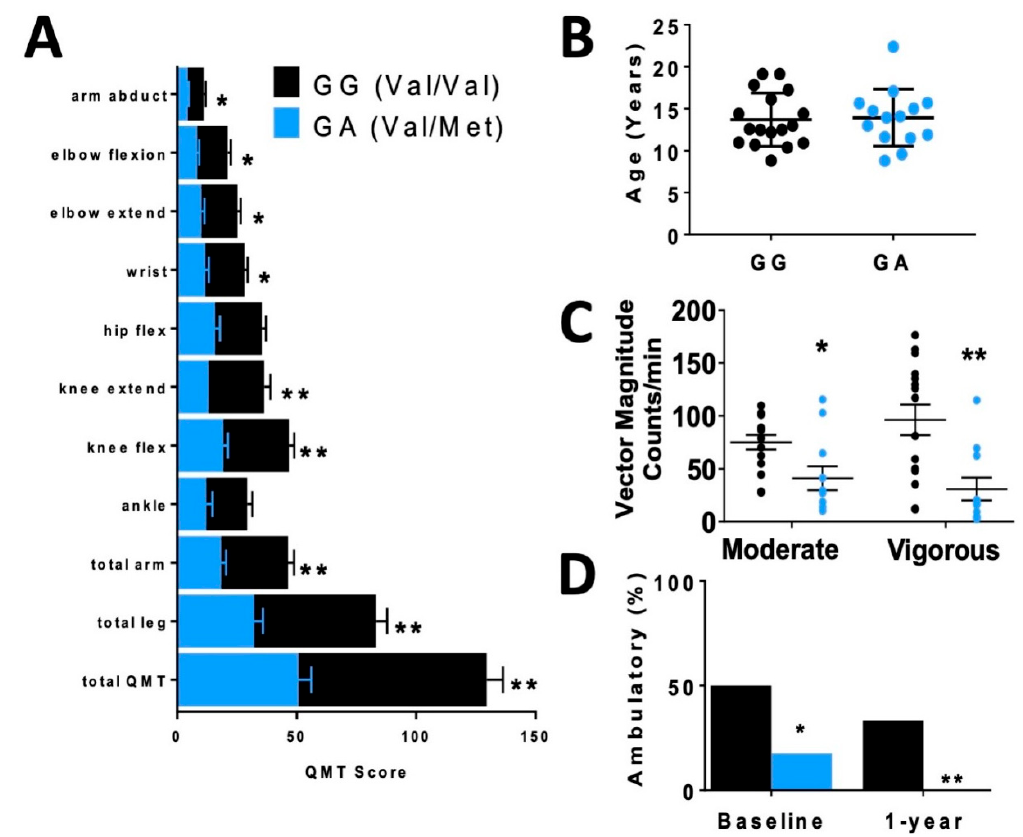
Figure 2. Disparate skeletal muscle performance in DMD patients when compared by rs6265 polymorphism. ( A ) Comparative bar graphs of quantitative muscle testing (QMT) scores for several muscle groups compared by rs6265 phenotype for GG (Val/Val) and GA (Val/Met). All muscle groups in the Val/Met patients showed significantly lower scores. ( B ) There was no difference in mean age between the phenotype groups. ( C ) Accelerometry data demonstrated Val/Met patients had significantly lower performance with moderate and vigorous exercise compared to Val/Val patients (41 ± 11 counts/min, n =11, vs. 75 ± 7 counts/min, n = 15, * p = 0.031, and 31 ± 11, n = 11, vs. 96 ± 15, n =15, ** p = 0.003, respectively). Comparisons by two-way ANOVA. ( D ) Age-similar Val/Met DMD patients were less likely to be ambulatory at baseline assessment and at 1 year follow-up.